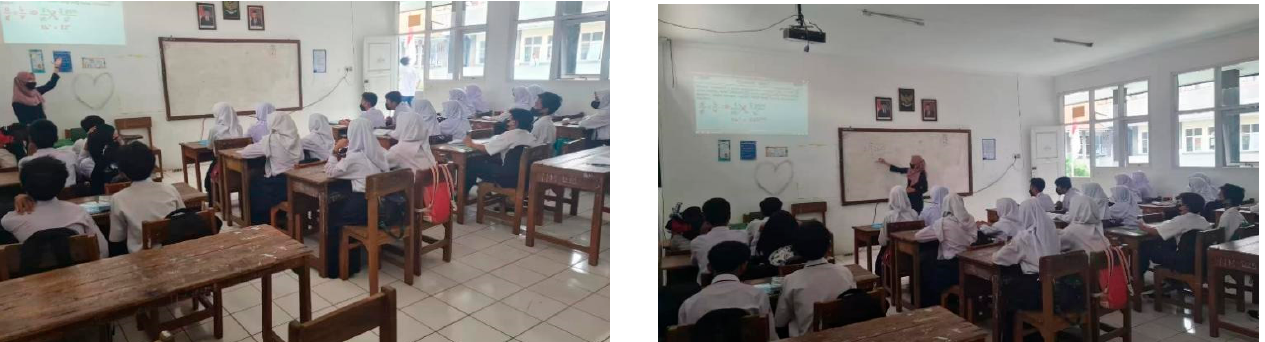
Figure 4. The teacher instructs students to watch the videos on the concept of direct and inverse proportion, and they actively ask and discuss some questions ( left ). There was a misunderstanding, and the teacher helped to resolve the issue ( right ). The learning activities remained student-centered.